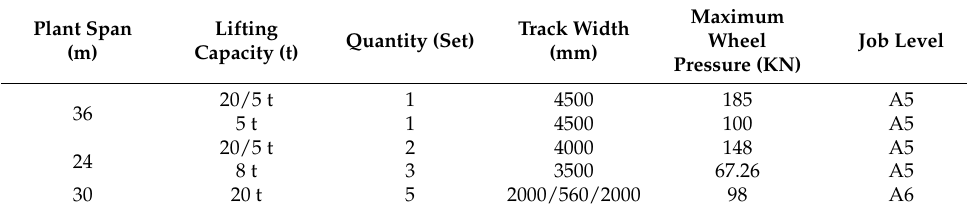
Table 1. Crane layout of main